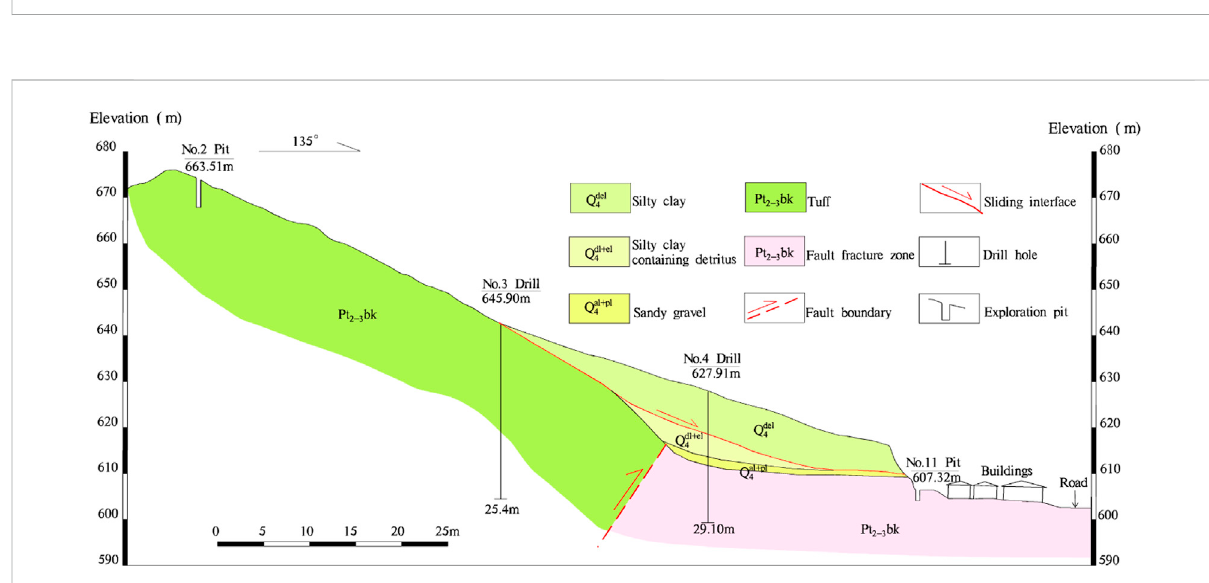
unloading tension cracks on the top surface of the slope (Figure 2C). Under the in fl uence of precipitation, there is a small-scale collapse deformation towards the leading edge of the eastern end of the landslide (Figure 2D).